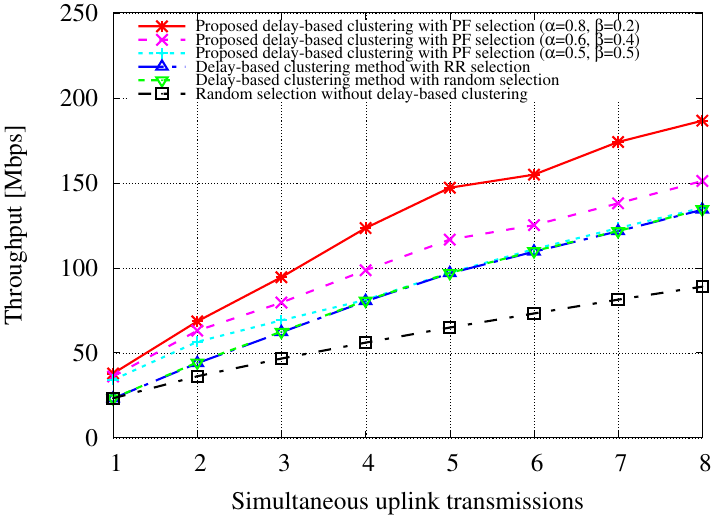
Figure 6. Network throughput performance ( S =